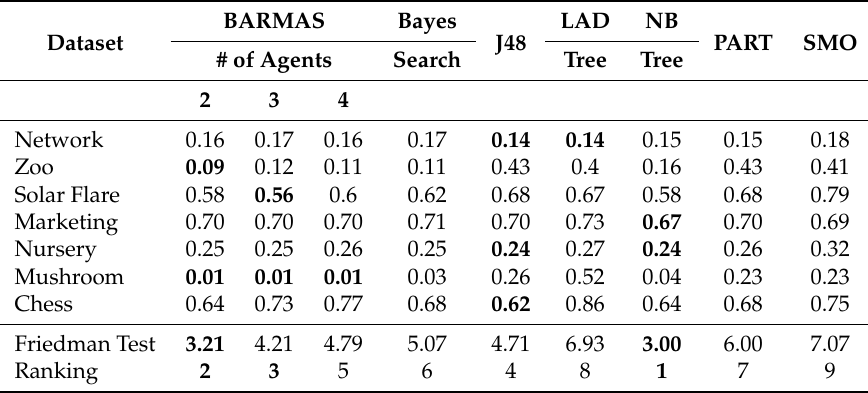
Table 4. Results with 25% missing attributes. Best results are marked in bold.